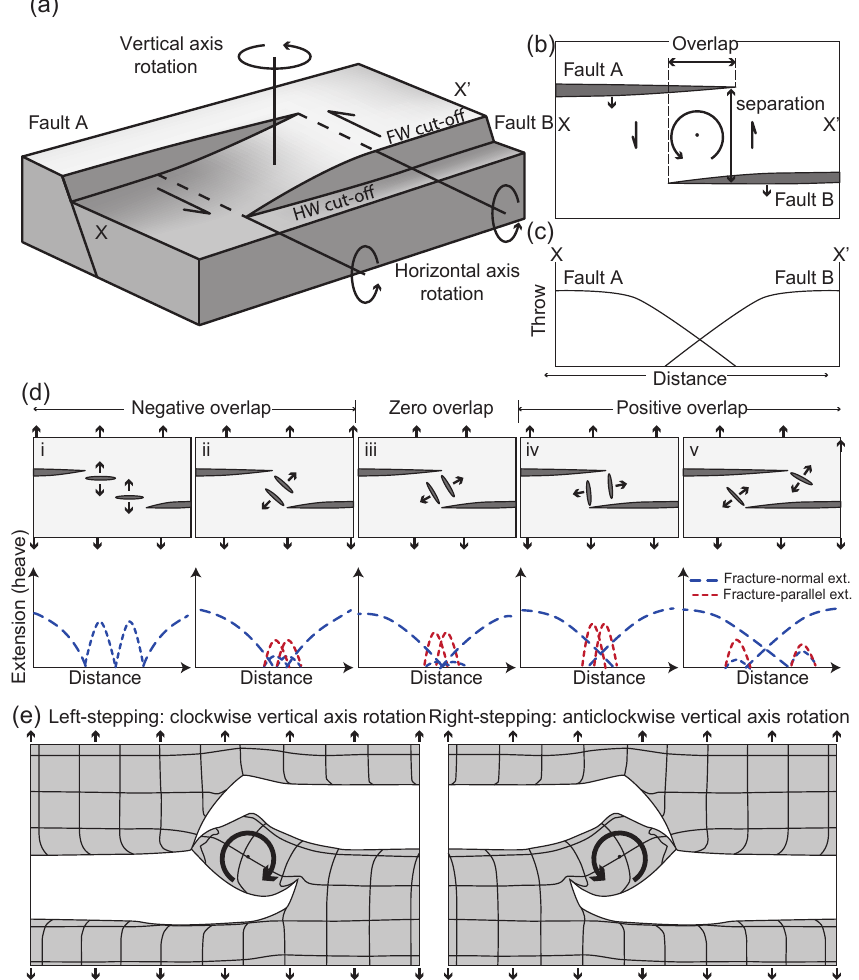
Figure 1. (a) Schematic diagram illustrating a relay zone between two normal faults (after Ferrill and Morris, 2001) showing the location of the footwall (FW) and hanging wall (HW) cut-off lines. (b) Map view of the block model in (a) showing fault overlap and separation. (c) Distance versus displacement (throw) profile for transect X-X’. (d) (i–v) Second-order fault geometries as a function of fault overlap (redrawn from Tentler and Acocella, 2010) with local and regional extension directions indicated. Graphs show schematic plots of displacement (extension or heave) length for the bounding fractures and linking geometries shown. (e) Modelled strain fields and rotation ahead of two left- and right-stepping en échelon open-mode fractures (redrawn from Tentler and Acocella,